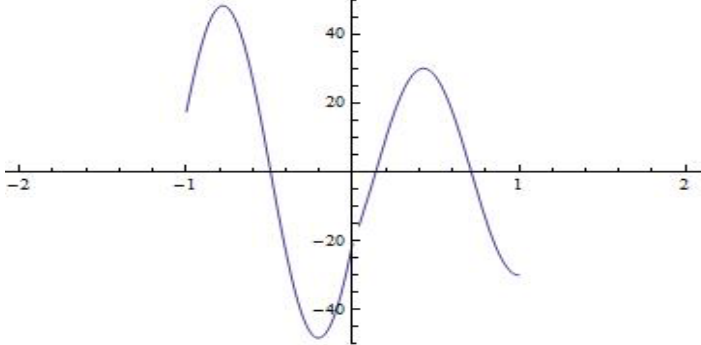
Figure 5. Graph of the second fundamental solution y = χ ( x , λ ) for λ = 3. (This graph was sketched by using “Mathematica 8”).